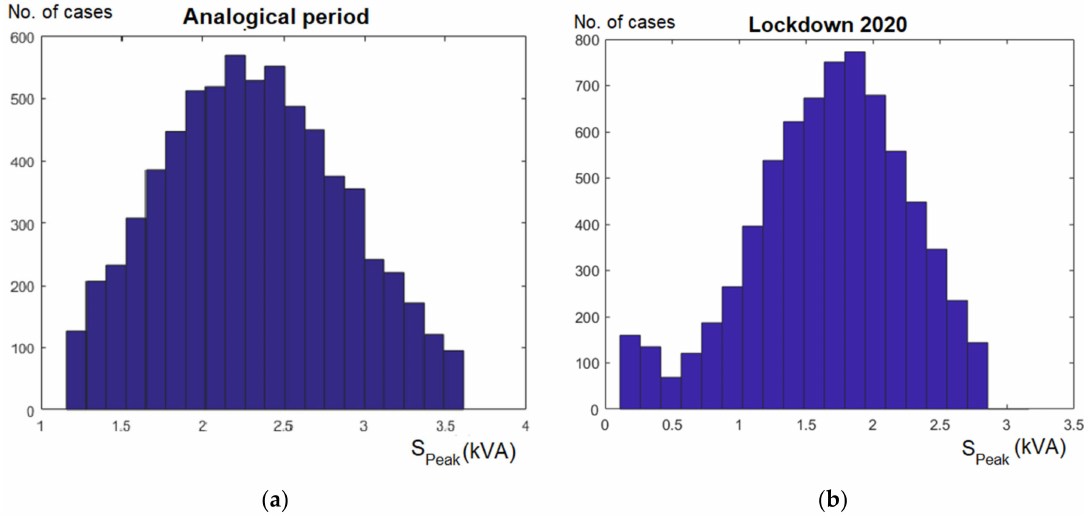
Figure 3. Histograms of apparent power peaks registered in users during ( a ) 2018 and ( b ) the lockdown in